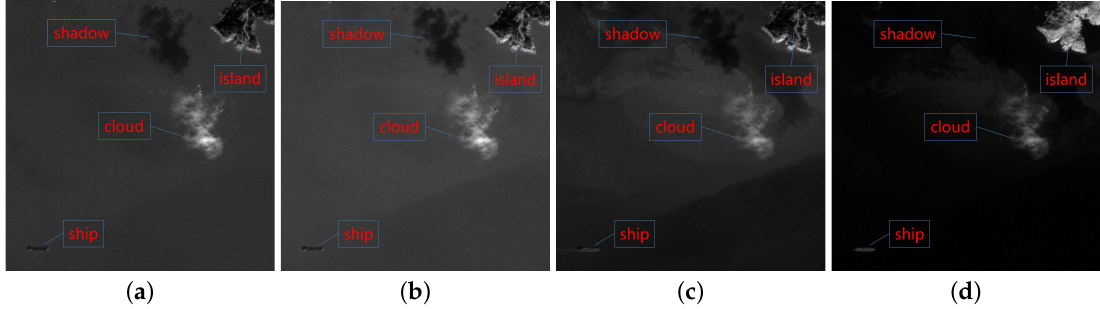
Figure 1. Four bands of a multispectral satellite image with cloud and wave backgrounds: ( a ) the grayscale image of the blue band; ( b ) the grayscale image of the green band; ( c ) the grayscale image of the red band; and ( d ) the grayscale image of the near-infrared